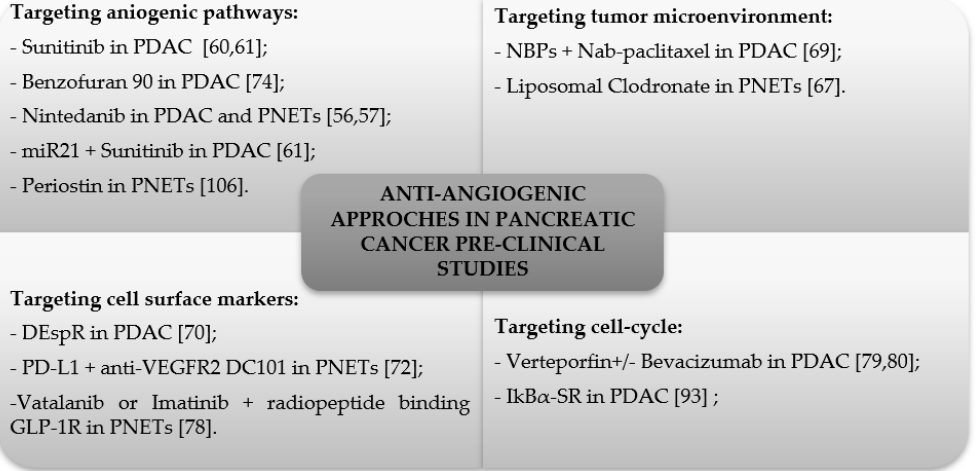
Figure 1. Anti-angiogenic approaches in pancreatic cancer pre-clinical studies of last 5 years discussed in the text .